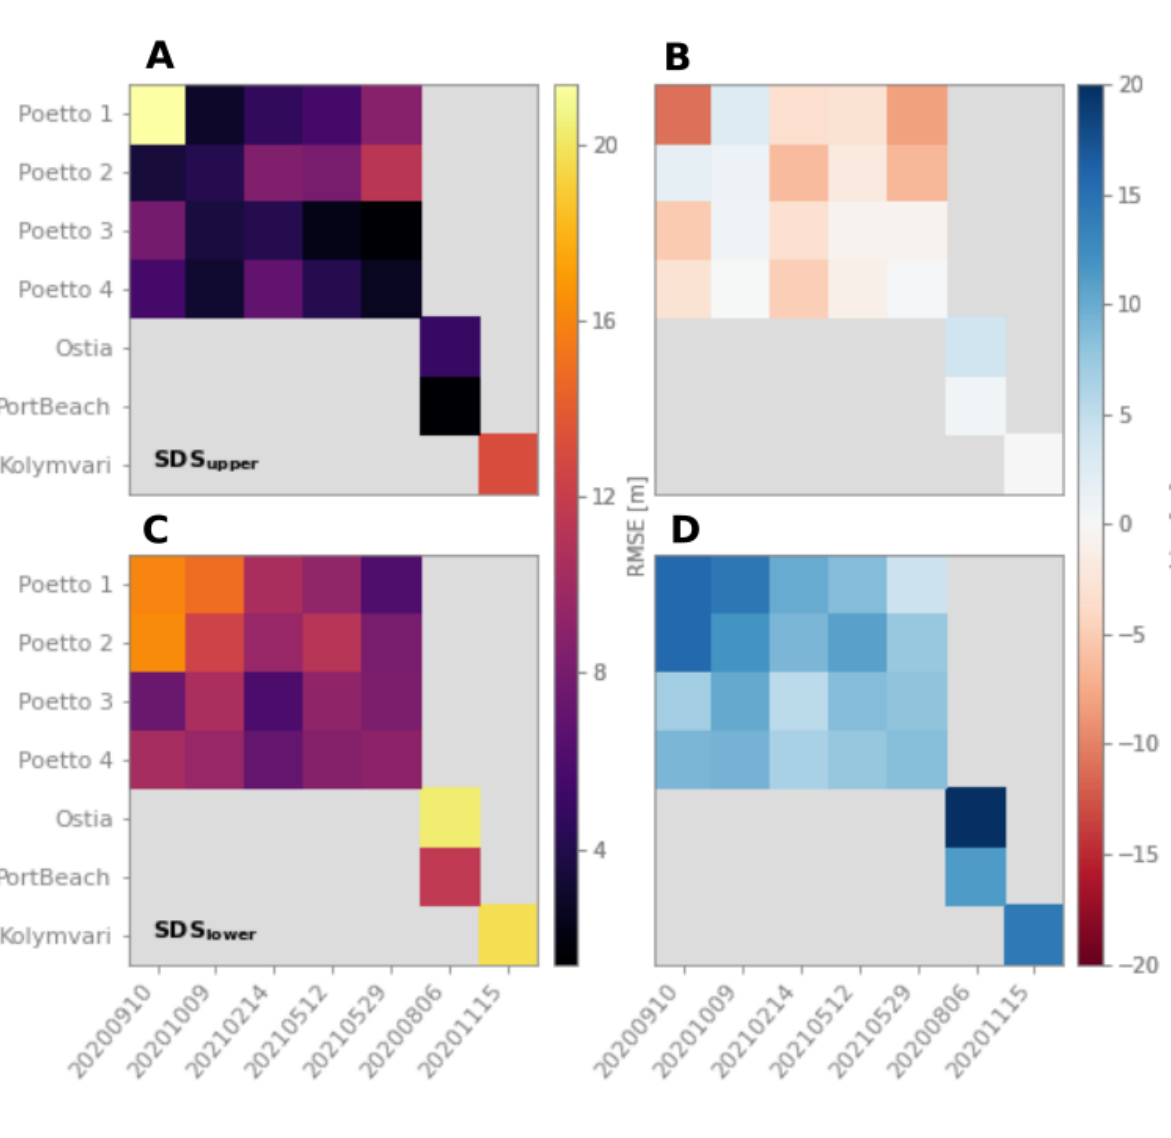
Figure 9. RMSE ( A , C ) and bias ( B , D ) obtained from the comparison of the k-means SDS upper and SDS lower with the GT (user-digitized)